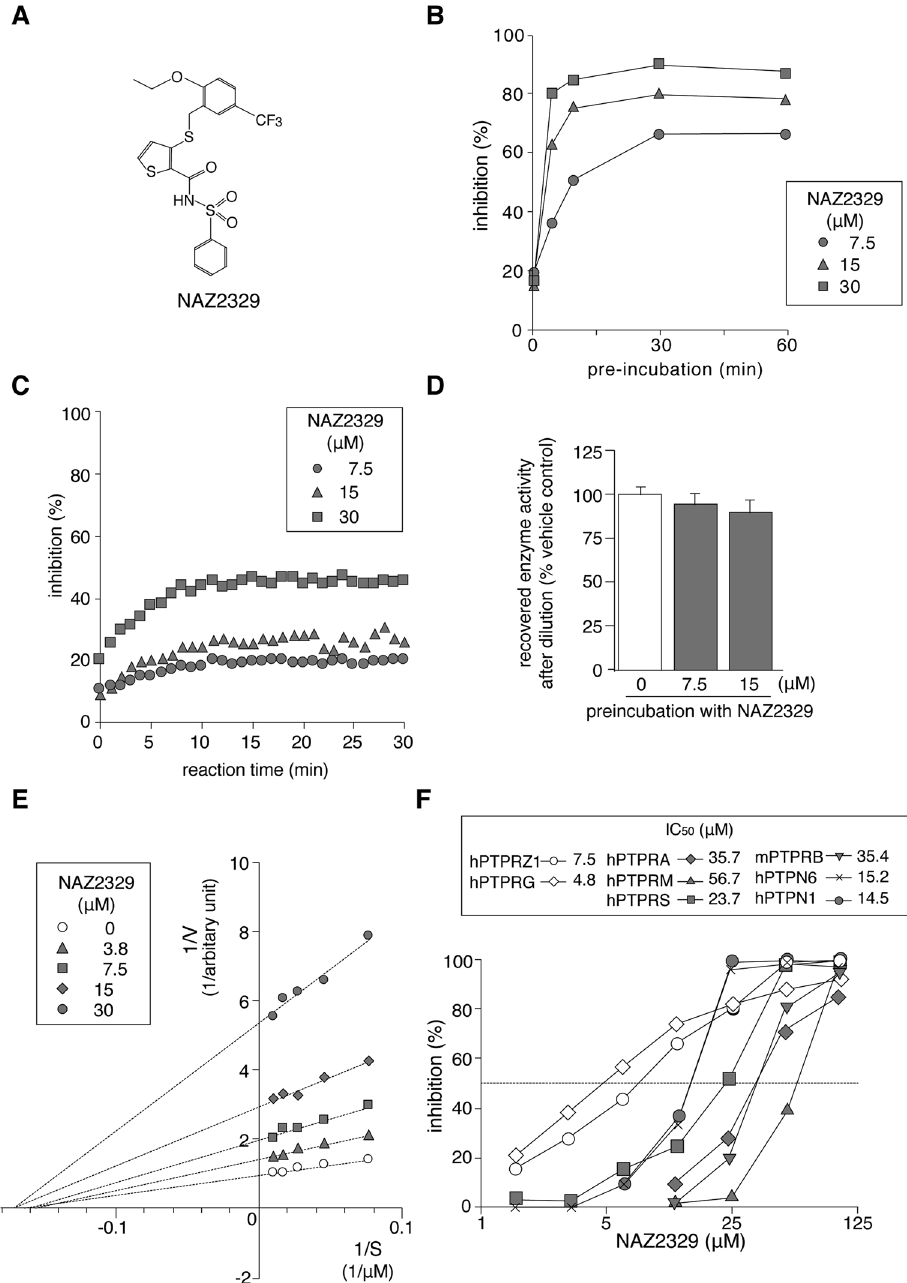
Figure 4. NAZ2329, an allosteric inhibitor of R5 RPTP subfamily members. ( A ) Structure of NAZ2329. ( B ) Effect of preincubation of NAZ2329 on its inhibitory activity against PTPRZ. Recombinant human PTPRZ1 enzyme (the whole intracellular region) was premixed with NAZ2329 for the indicated times and followed by addition of a fluorogenic DiFMUP (non-specific PTP substrate, 6,8-difluoro-4-methylumbiliferyl phosphate) to measure PTP inhibitory activity. ( C ) Time dependence. The PTPRZ1 enzyme was added to the inhibitor–substrate mixture, and the inhibitory activity was determined at each time point relative to the vehicle control. ( D ) Reversibility of inhibition. PTPRZ1 enzymes were preincubated with NAZ2329 at the indicated concentrations for 30 min. The mixture was then 20-fold diluted, and recovered PTP activity was expressed as the relative activity compared with the vehicle-treated enzyme. ( E ) Lineweaver-Burk plot analysis. PTPRZ1 enzymes were preincubated with NAZ2329 for 60 min, and the PTP activity was measured using DiFMUP. ( F ) Concentration-inhibition curves of NAZ2329 for representative PTP members, including human PTPRZ and PTPRG (another R5 RPTP subfamily member), human PTPRS (R2A subfamily), human PTPRM (R2B subfamily), mouse PTPRB (R3 subfamily), human PTPRA (R4 subfamily), human PTPN1 (non-transmembrane PTP, NT1 subfamily), and human PTPN6 (NT2 subfamily), were generated. Assays were performed using DiFMUP. IC 50 values obtained are shown in the inset. Data represent the averages of two or three separate